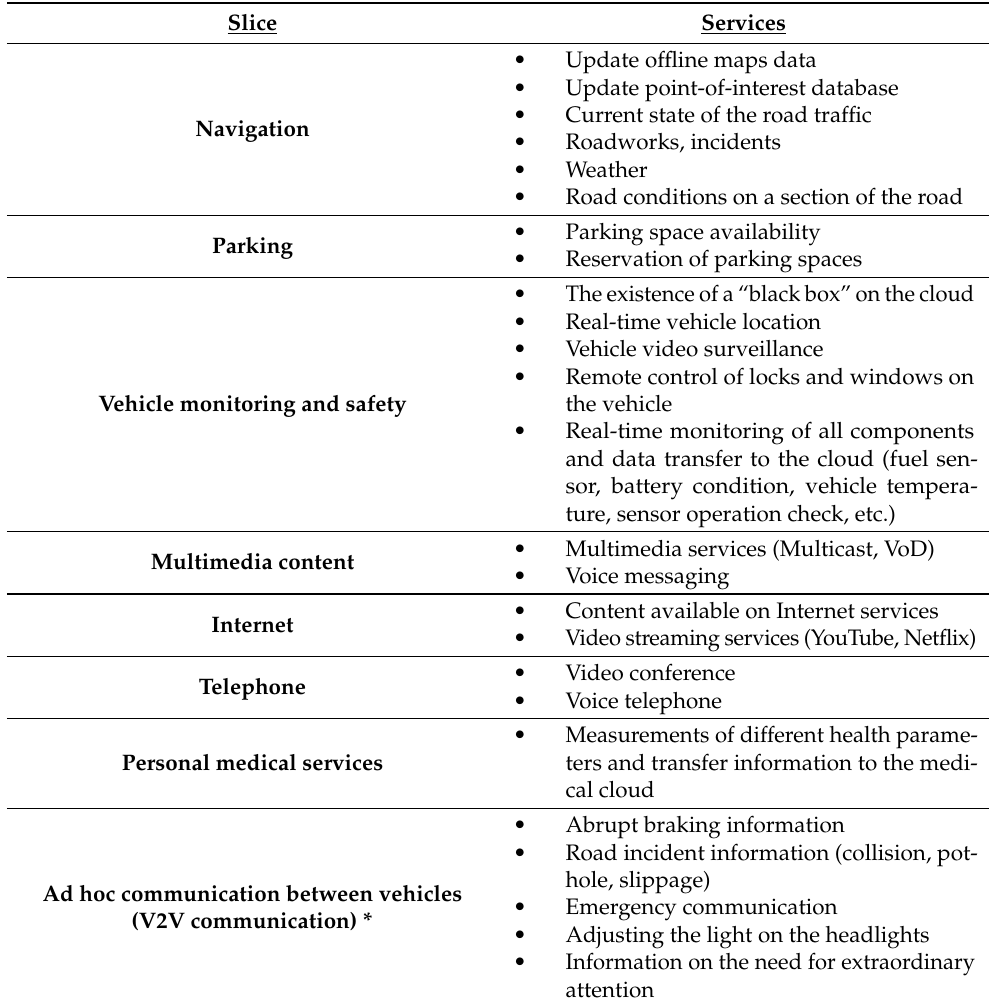
Table A1. The example of service grouping as slices for smart vehicle use